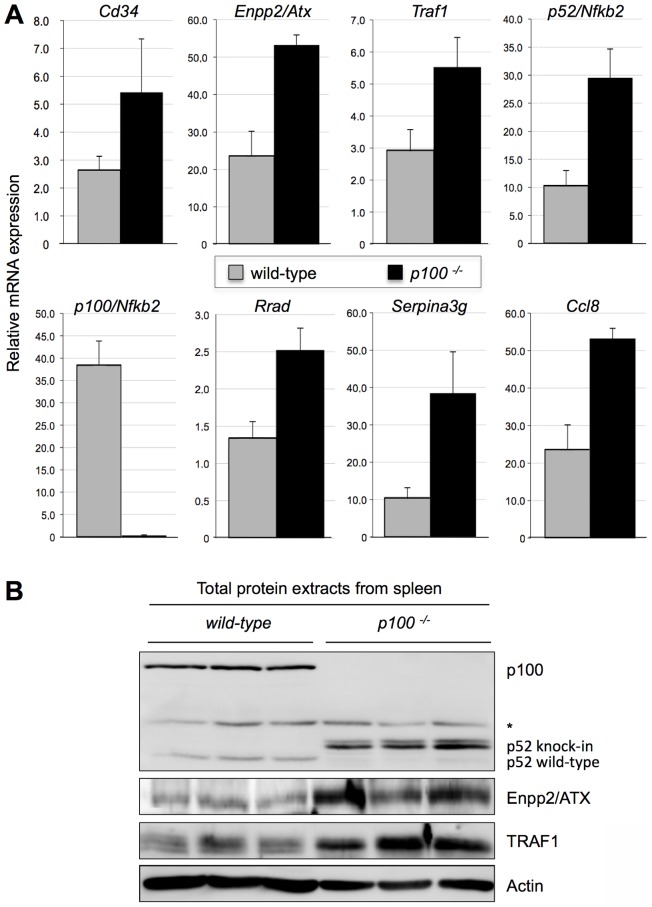
Gene expression analysis of wild-type and p100−/− spleens.(A) Changes in mRNA levels of selected genes were analyzed by qRT-PCR using RNA samples isolated from spleens of four wild-type and four p100−/− animals. Data are expressed as mean values ± SD. Differences were analyzed by Welch tests. P≤0.05 was considered significant. All genes shown were significantly differentially regulated in wild-type compared to mutant mice. (B) Western blot analysis of total protein extracts from wild-type and p100−/− spleens (30 µg/sample; protein extracts from three independent spleens are shown for each genotype) for the presence of p100/p52, ENPP2/ATX, and TRAF1. p52 wild-type protein and p52 protein resulting from the knock-in of the stop codon migrated with different speed due to a few amino acids difference in length. The asterisk indicates an unspecific signal. The membrane was probed for β-actin as a loading control.